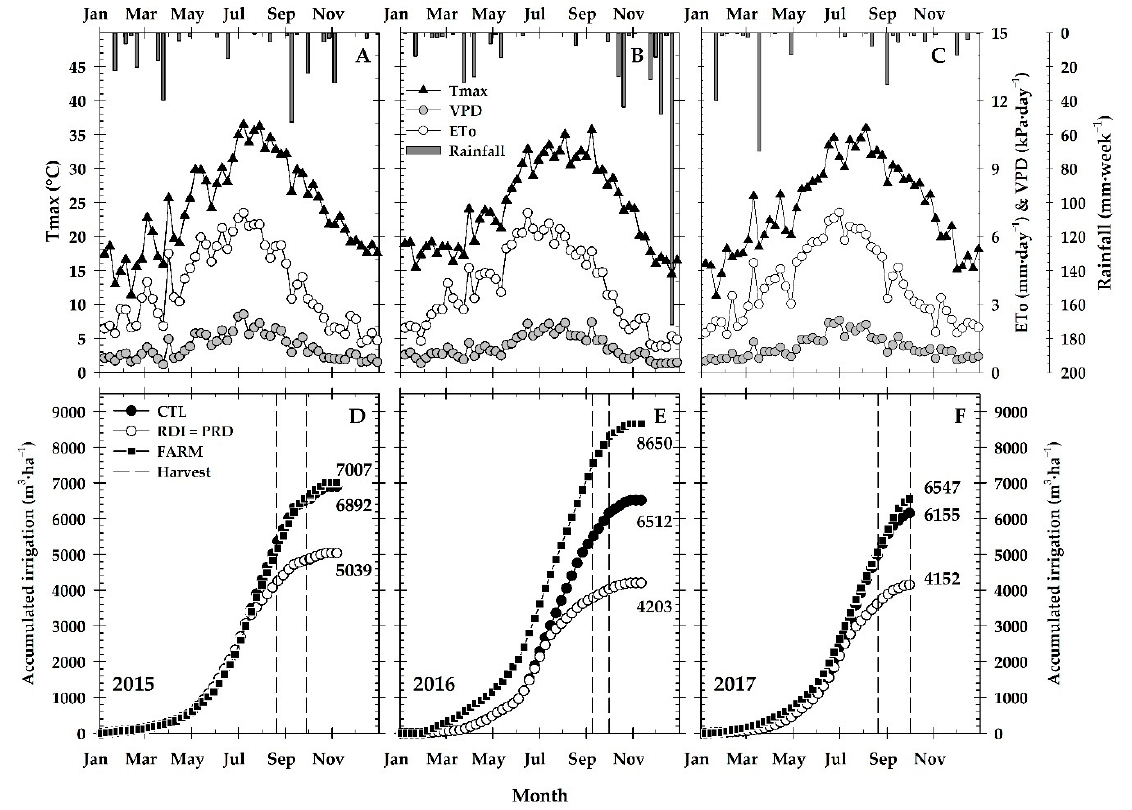
Figure 1. Seasonal evolution of daily reference crop evapotranspiration (ET 0 ), vapor pressure deficit (VPD), maximum tem- perature (Tmax) and weekly rainfall during the three years assayed (2015–2017) ( A – C ). Precipitation events are shown as vertical bars. Seasonal variation of cumulative water applied during the same experimental period ( D – F ). The total amount of water applied in all the treatments is also indicated. Vertical dashed lines indicate harvest